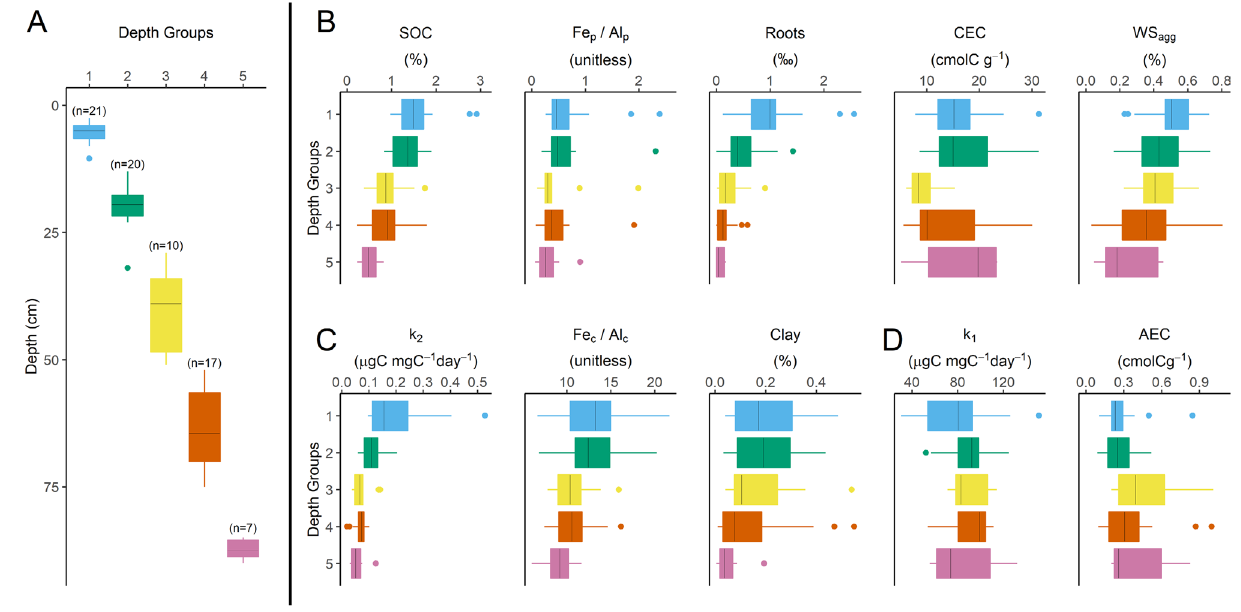
Figure 5. Hierarchical clustering of C response, physicochemical predictors, and depth. Median values, first and third quantiles, and 95% confidence intervals are shown for each hierarchical depth group ( A ), SOC and best physicochemical predictors ( B ), k 2 alongside best predictors ( C ), and k 1 and best predictors ( D